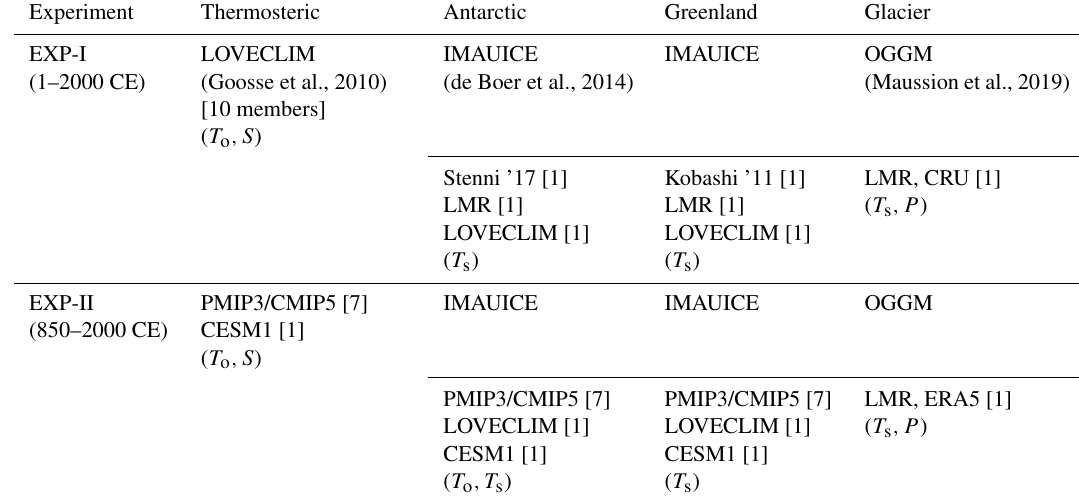
Table 1. Details of the two groups of model experiments presented in this study. The columns are split into two rows for the barystatic components for EXP-I and EXP-II, highlighting the physical model used (top row) and the input used to run the model (bottom row). The numbers in square brackets show the number of independent simulations made either using different models (e.g. PMIP model simulations) or based on the input field given to the physical model (ice sheet/glacier model run with different input fields) for each component. Abbreviations (for the variables used) are: T o – ocean temperature, S – ocean salinity, T s – surface temperature, P – precipitation, Stenni ’17 – Stenni et al., 2017, LMR – last millennium reanalysis, Tardif et al., 2019, Kobashi ’11 – Kobashi et al., 2011, CRU – Climatic Research Unit gridded time series v-4.01 (Harris et al., 2020), PMIP3/CMIP5 – Paleoclimate/Coupled Model Intercomparison Project (Taylor et al., 2012; Braconnot et al., 2012), CESM1 – Community Earth System Model (Otto-Bliesner et al., 2016), ERA5 – ECMWF atmospheric reanalysis – v5